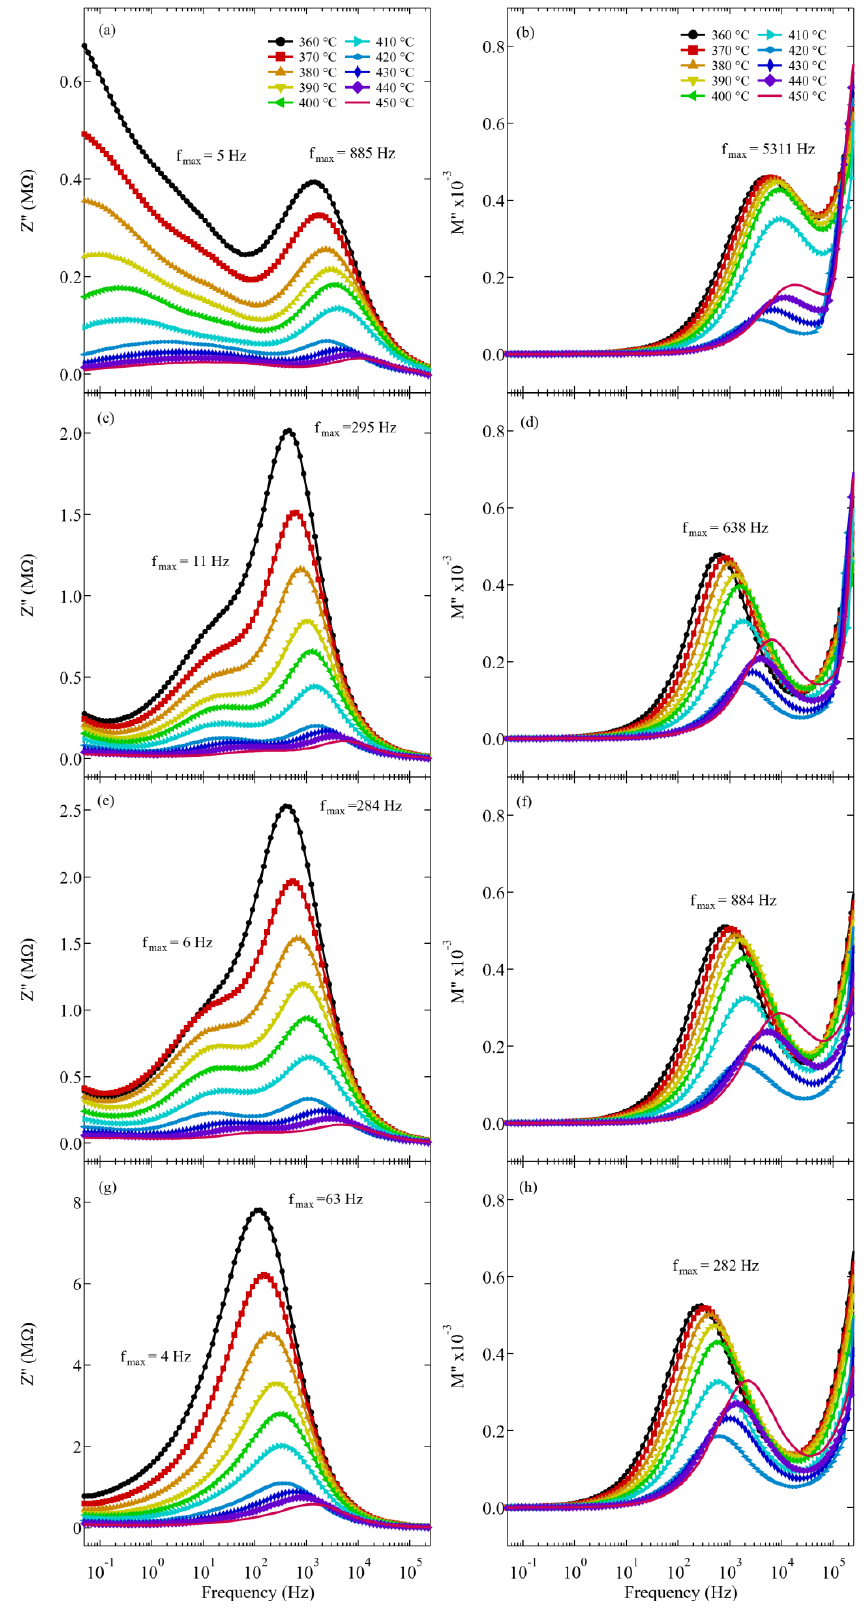
Figure 3. Imaginary part of the impedance and electrical modulus of NKN with ( a , b ) 0 vol%, ( c , d ) 5 vol%, ( e , f ) 15 vol%, and ( g , h ) 25 vol% Al 2 O 3 as a function of